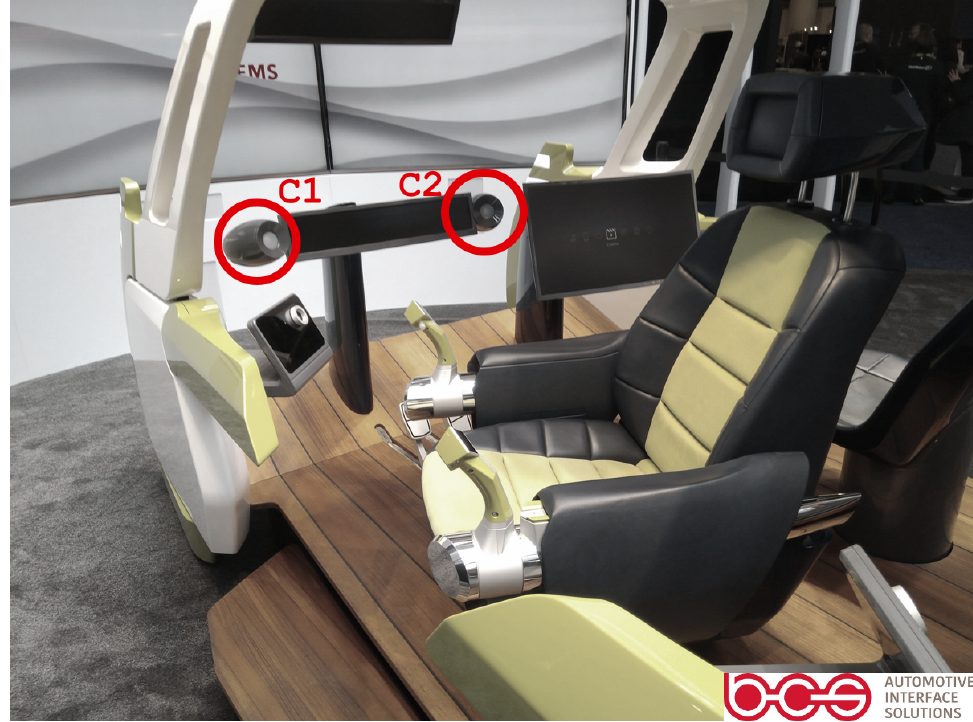
Figure 1. Interior of the mockup. The driver’s chair currently is in boarding position and at its front the drive sticks are visible. On the co-driver’s side the multimedia display is mounted. The front pillar is T-shaped and on its outer sides the IR cameras (s. C1 and C2) are attached behind a polymer film (IR window). (Permission by BCS Automotive Interface